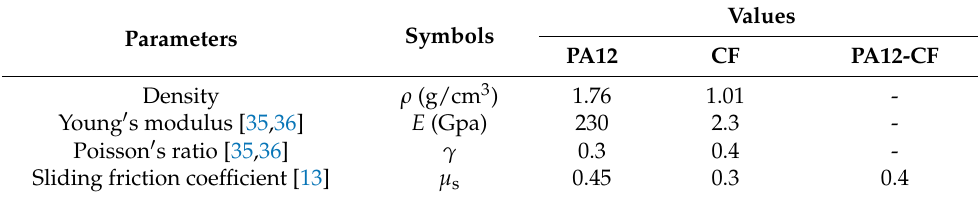
Table 1. Processing parameters employed in the simulations. Parameters Symbols